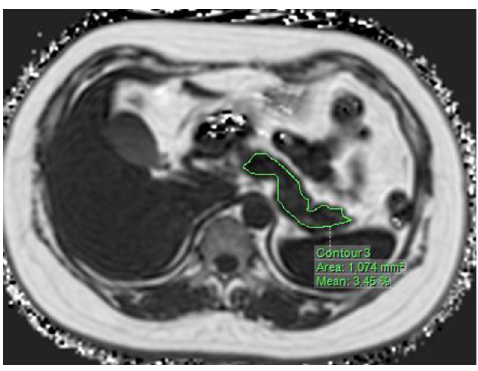
Fig 1. In the T1WI/FF sequence, the software can automatically calculate the fat content in the measured area by selecting the pancreas measurement range.